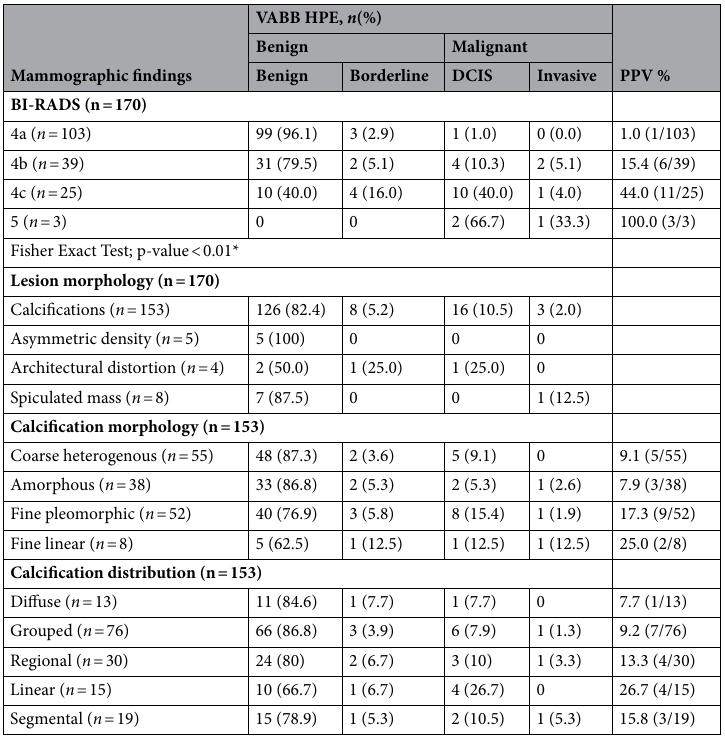
Table 3. VABB HPE with mammographic findings including BI-RADS category, lesions morphology and distribution and morphology of calcifications. * p-value of < 0.05 was applied as a threshold for statistical